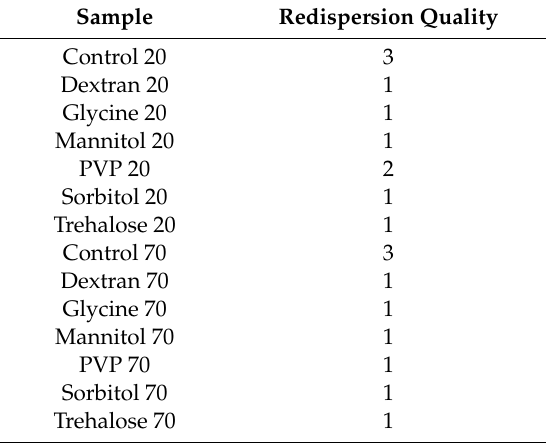
Figure 5. Intensity distribution of cryoprotected SA-P SLNs after lyophilization at the − 20 ◦ C (slow freeze) condition. Table 6. Freeze–thaw study: Effect of cryoprotectant on redispersibility of SLNs after lyophilization. Redispersion qualitative scale: 1—fully redispersed within 30 s of vortexing; 2—a few remaining undispersed visible agglomerates still present after 30 s of vortexing; 3—very little or no redispersion of solid after 30 s of vortexing.